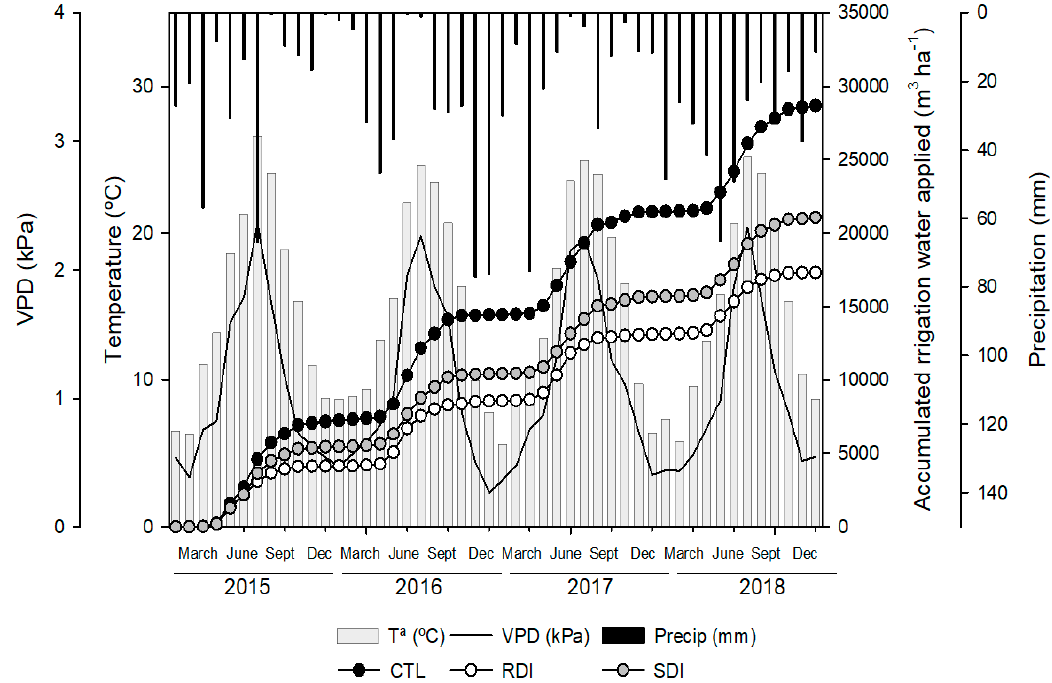
Figure 1. Seasonal evolution of monthly mean temperature (T a ), monthly mean air vapour pressure deficit (VPD) accumulated monthly rainfall (Precip) and accumulated irrigation water applied to each treatment during the experiment (2015–2018) at the ‘Prime Giant’/SL64 sweet cherry orchard in Jumilla (Spain).